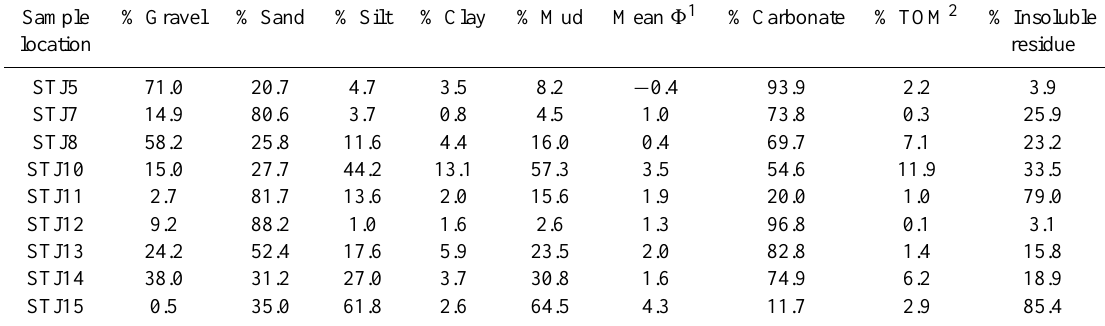
Table 3. Grain size of surface sediments. Sample